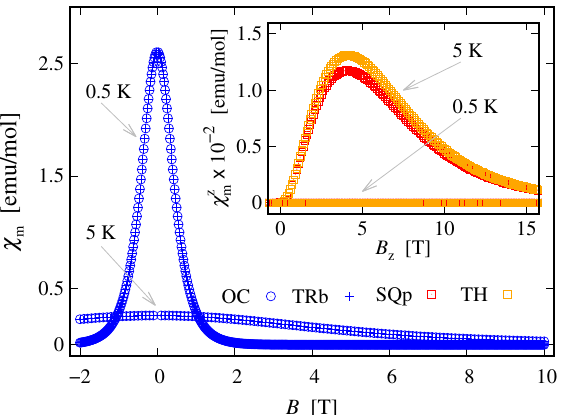
Figure 4. Low-temperature molar susceptibility as a function of the externally applied magnetic field for the octahedral (OC), trigonal bipyramidal (TRb), square planar (SQp) and tetrahedral (TH) complexes. The calculations are performed for parameters’ values given at the end of Section 2.1 and with a fraction between the corresponding molar mass and density equal to unity. The inset shows how the effect of raising the temperature to 5 K in the case of square planar and tetrahedral complexes affects the susceptibility. For convenience, only the z component of susceptibility is depicted. In particular, at T = 5 K the peaks corresponding to χ x m and χ y m shift, with centers of approximately 3